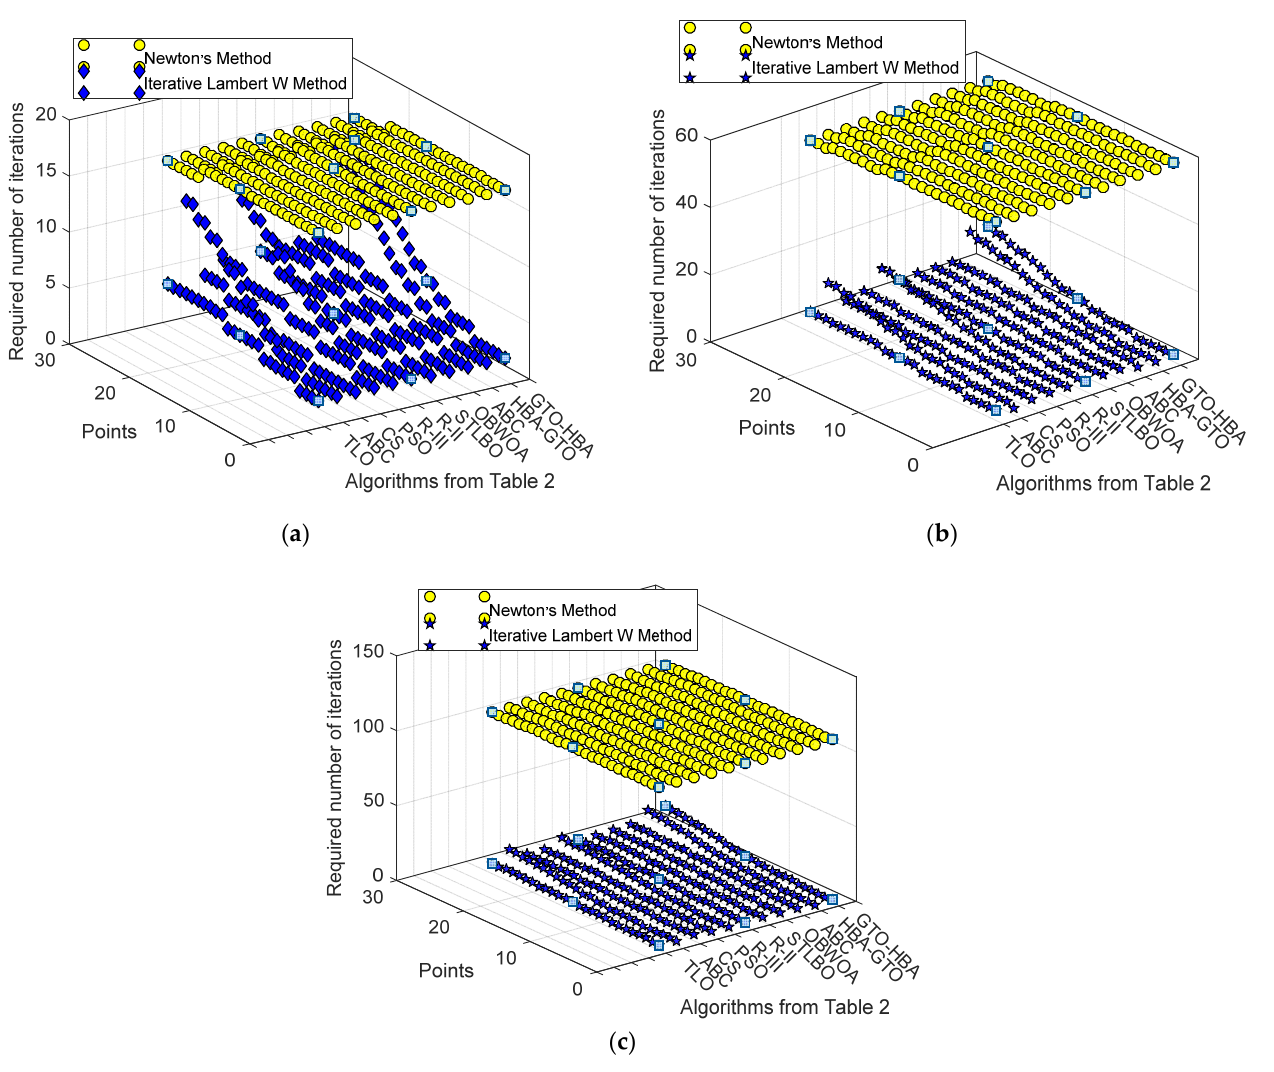
Figure 19. Required number of iterations for all voltage values with 10 − 10 stopping criterion using Newton’s and iterative Lambert W methods: ( a ) x 0 = 10; ( b ) x 0 = 50; ( c ) x 0 = 100. Table 9. Minimum and maximum number of iterations for NM and ILWF observing all the measured points of the TDM representing the RTC France solar cell.